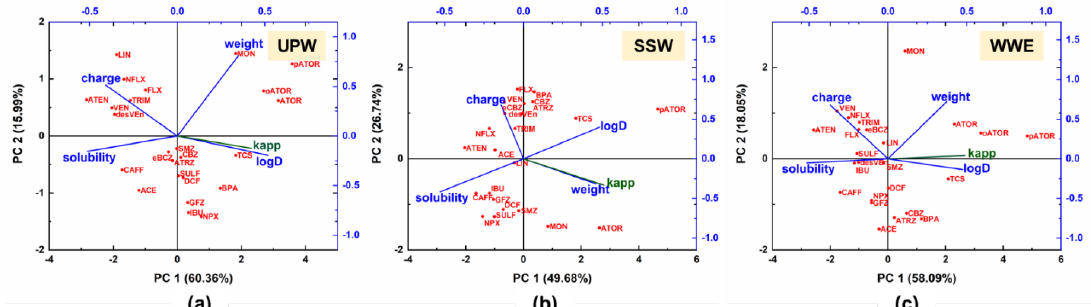
Figure 4. Principal component analysis (PCA) biplot showing the multivariate variation among 24 PPCPs in terms of physicochemical properties (net charge, weight, solubility, and log D ow ) in ( a ) ultrapure water ( b ) synthetic surface water ( c ) wastewater effluents. Blue vectors indicate the direction and strength of each variable (physicochemical properties) and their correlation to k app (green vector).